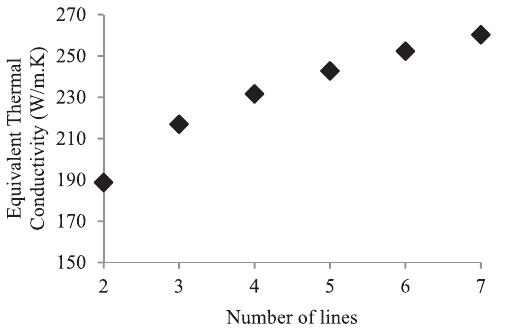
Fig. 6: Influence of the number lines, volume fraction of PCM and number of columns constant